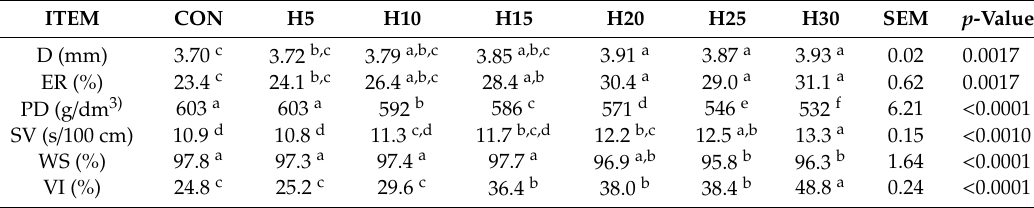
Table 4. Physical properties of experimental feeds containing black soldier fly full-fat meal.